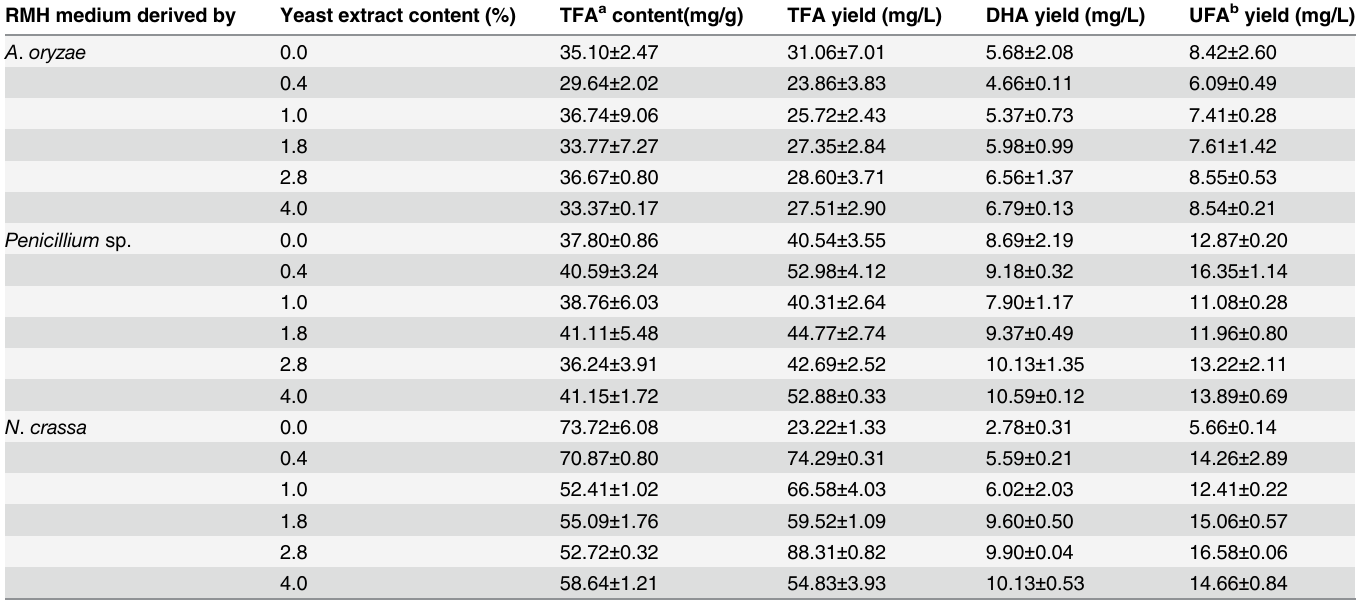
Table 1. Effect of supplemented yeast extract on lipid production by C . cohnii on individual RMH medium. RMH medium derived